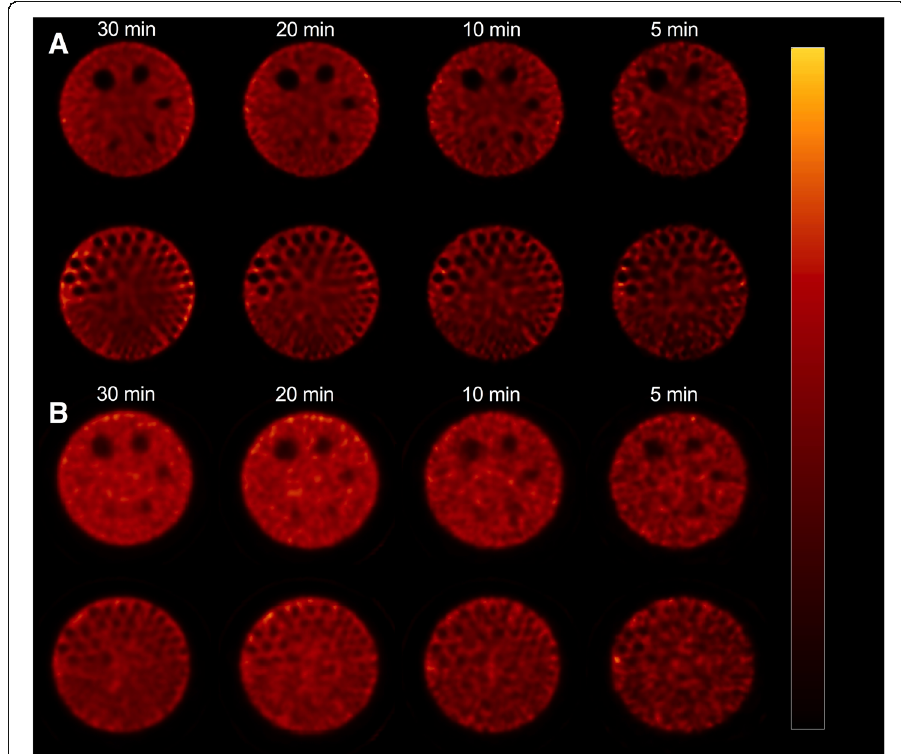
Fig. 3 Axial reconstructed slices (similar scale with min and max threshold respectively set to 0 and 125%) of the Jaszczak phantom obtained for CzT ( a ) and Anger cameras ( b ) centred on cold spheres (top rows) or capillaries (bottom rows) for 30, 20, 10 or 5 min of acquisition time (left to